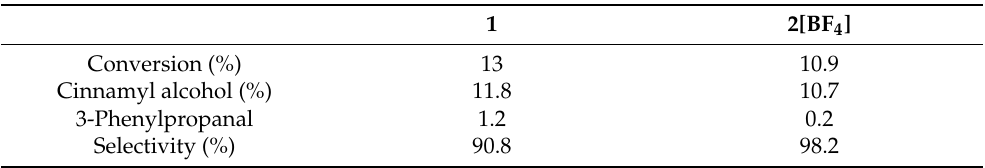
Table 1. Homogeneous hydrogenation of cinnamaldehyde with catalysts 1 and 2 , respectively, in 2-methoxyethanol solution.